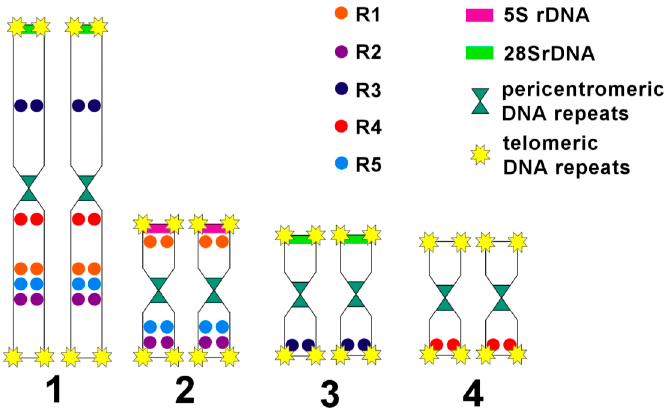
Figure 8. Scheme of the localization of the physical markers in the M. lignano chromosomes based on five unique DNA fragments and repeat clusters (5S and 28S rDNA, telomere and pericentromeric DNA repeats).